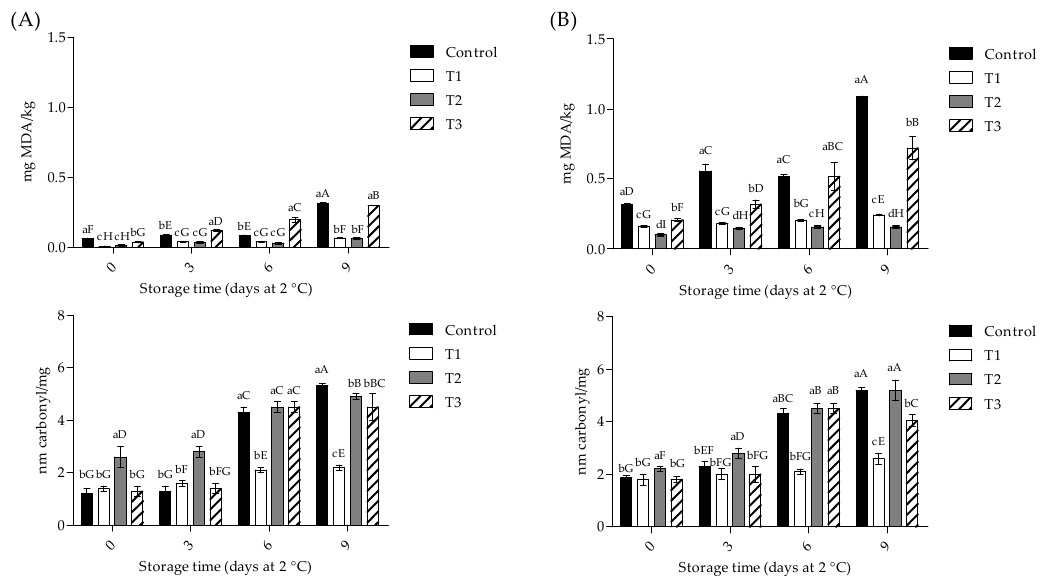
Figure 1. Lipid and protein oxidation of raw and cooked pork patties (( A ) and ( B ), respectively) during storage time. T1, POP at 2%; T2, POP at 5%; T3, BHT at 0.02%. Lowercase letters indicate differences between treatments on each sampling day; capital letters indicate differences in each treatment through the storage period ( p < 0.05).